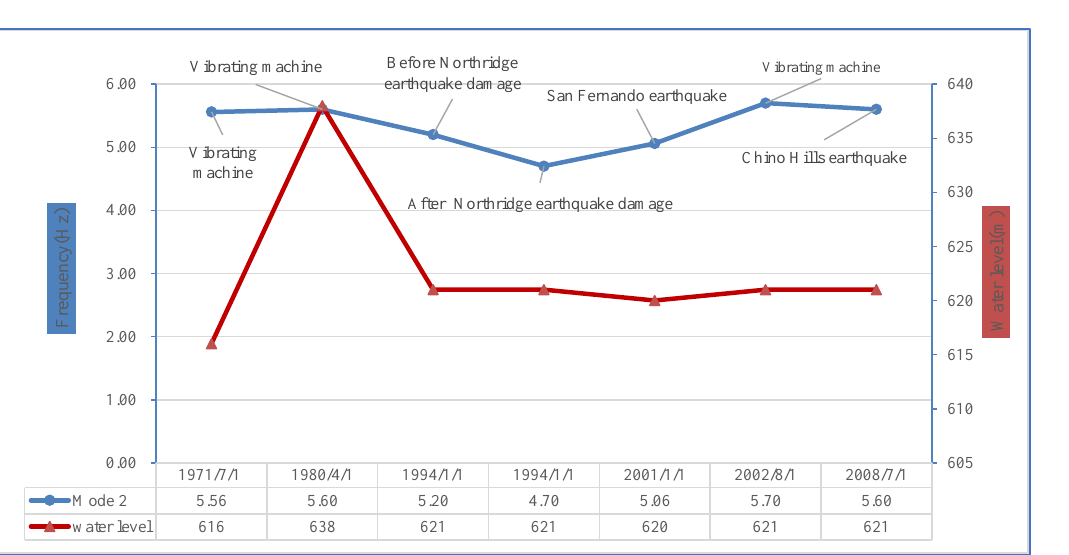
Figure 5. Evolution of the natural frequency and water levels (mode 2).